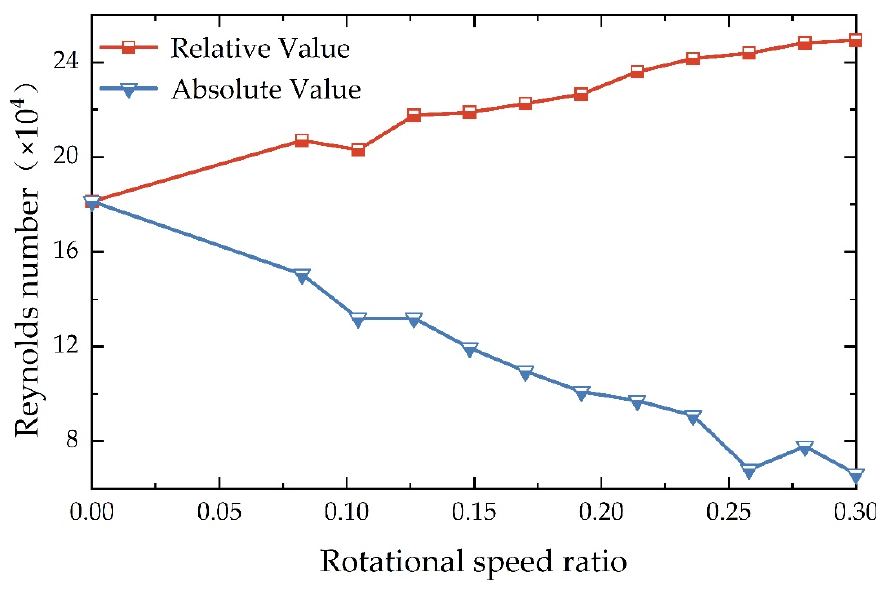
Figure 6. Trend of Reynolds number of water flow in the flume at different speed